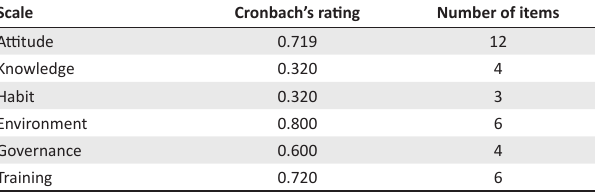
TABLE 2: Reliability and validity.